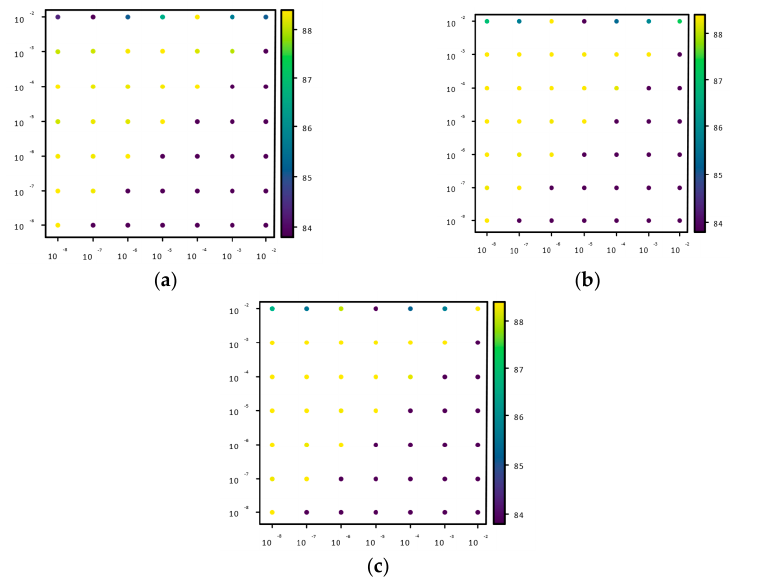
Figure 7. Model hyperparameter grid search results. ( a ) CIC-IDS-2017 Dataset Experimental Results. ( b ) KDDCUP99 Dataset Experiment Results. ( c ) Experimental results of NSLKDD dataset.